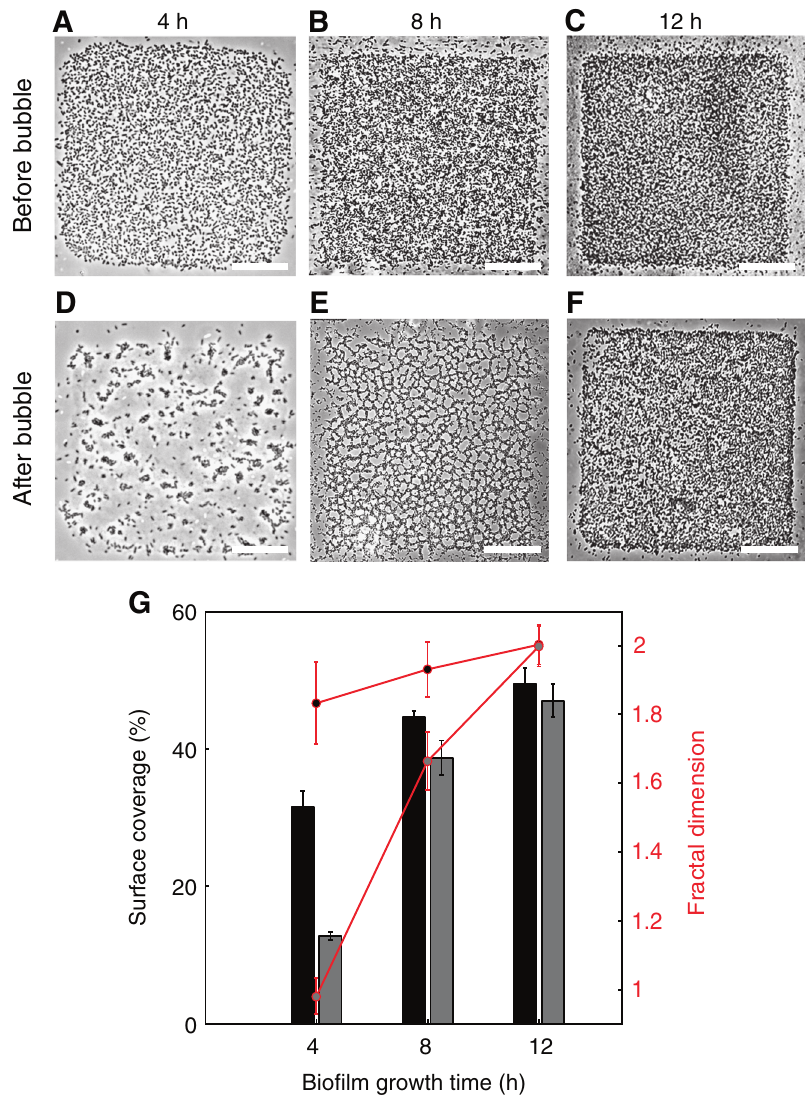
Fig. 2 The effect of the air bubble strongly depends on bio fi lm age. a – f Bio fi lms grown for different times (4 h, 8 h, 12 h), shown before ( a – c ) and after ( d – f ) the passage of a long bubble. The bubble traveled from left to right. Scale bars, 100 µm. g Surface coverage (fraction of the surface of a hydrophobic patch covered by bacteria) before ( black ) and after ( gray ) the passage of a bubble, for bio fi lms of different age (4 h, 8 h, 12 h). The red curve ( right axis ) shows the fractal dimension of the cell distribution measured before ( top red curve ) and after ( bottom red curve ) the passage of a bubble. Error bars correspond to the standard error of the mean over fi ve